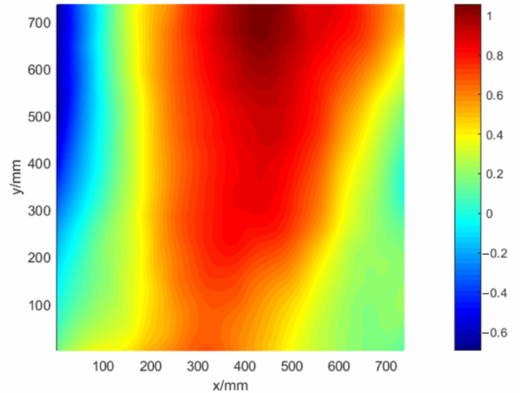
Figure 12. The full-field distribution of the measurement error.